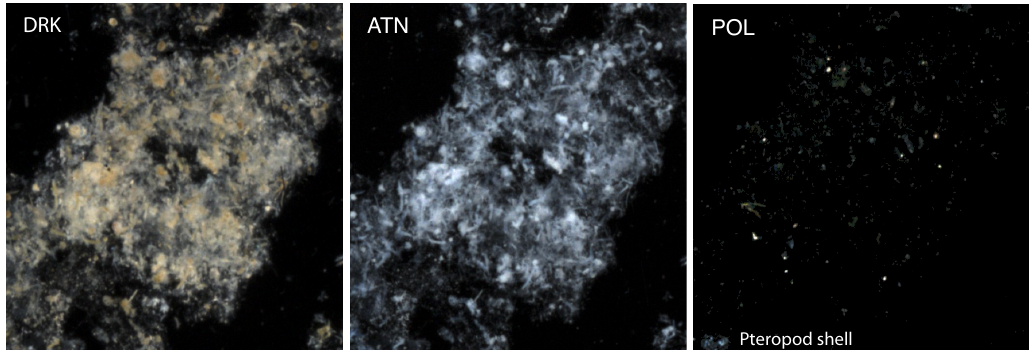
Figure 3. Magnified detail of a marine-snow aggregate from the upper left-hand quadrant of the sample image in Fig. 2 after processing to normalized dark field (DRK) counts, attenuance (ATN), and polarized (POL) counts. The scale of the aggregate is ∼ 1cm. Image resolution is 13µm. An empty 600µm pteropod shell is at the bottom left of the POL image. The 10 bright spherical regions in the POL image are ∼ 200µm sized foraminifera shells; haze in aggregates is likely due to